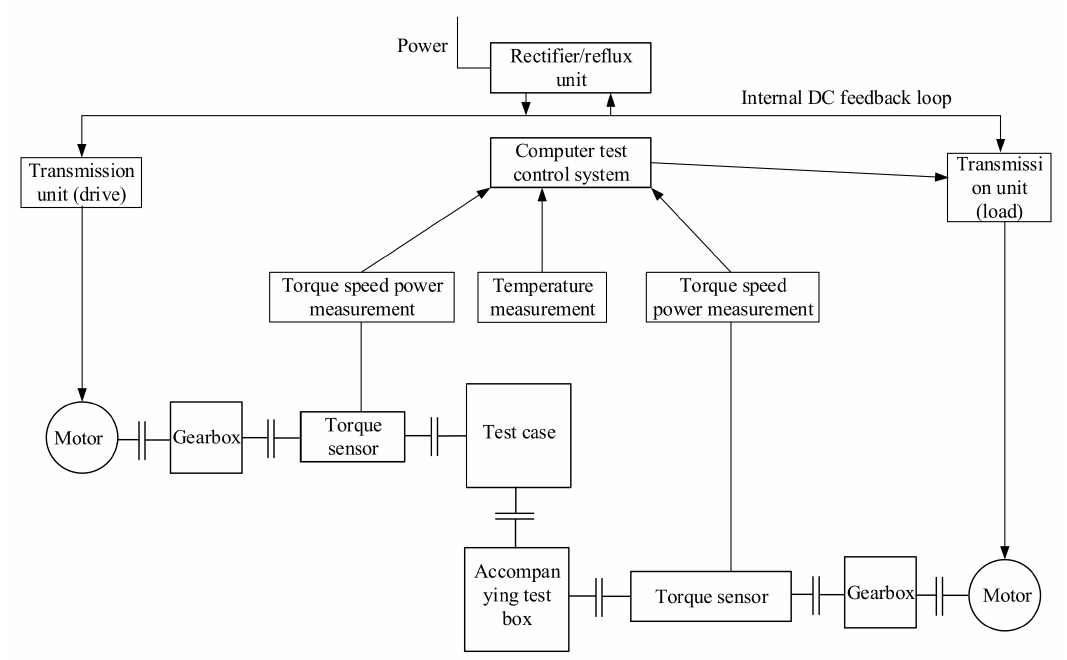
Figure 13. Schematic diagram of test bench